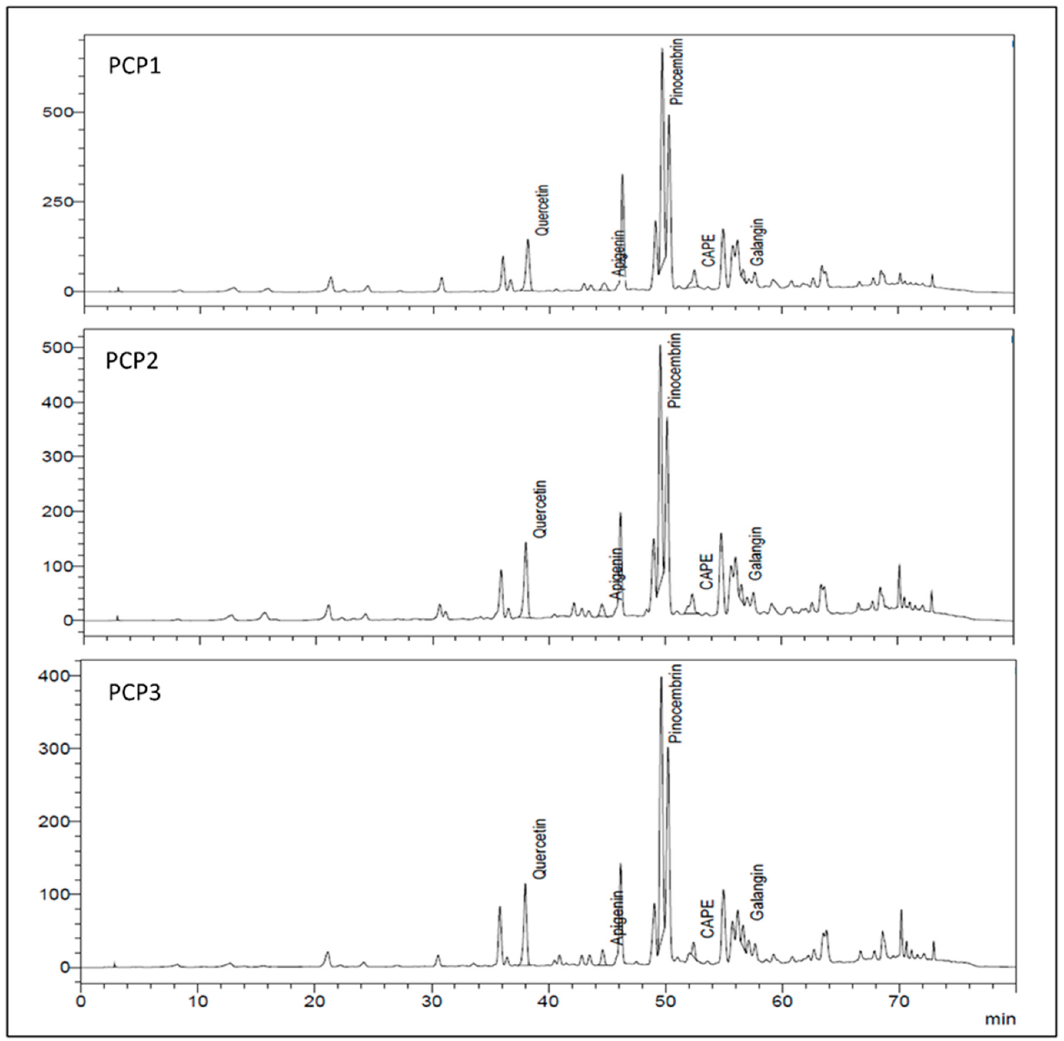
Figure 3. HPLC chromatograms of PCP1, PCP2 and PCP3. Concentrations of phenolic compounds were expressed in mg L − 1 .